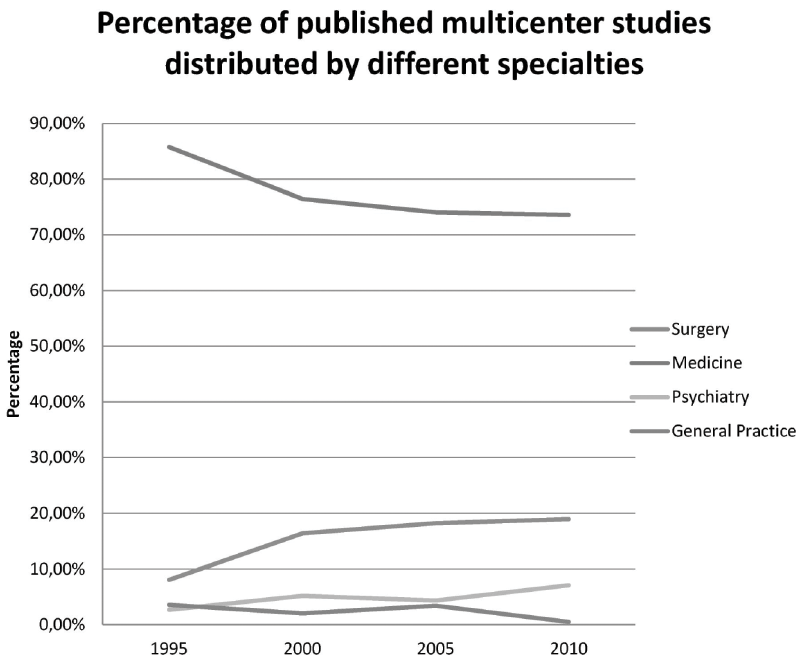
Figure 4. Percentage of published multicenter studies distributed by different specialties.